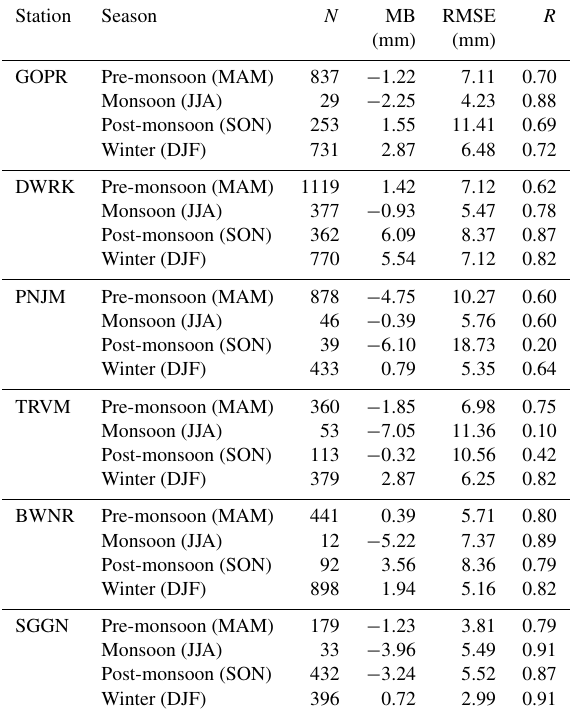
From Fig. 5, the Taylor diagram evaluates the skill character- istics in terms of RMSE, correlation coefficient and standard deviation of the annual distribution of IPWV retrieved from CAMS with 19 GNSS IPWV stations at different geographi- cal locations (Fig. 5) over the Indian subcontinent during the period of 1 January 2018 to 31 December 2018. The root mean square error (RMSE) between CAMS reanalysis and GNSS data retrievals of 9 inland stations out of 10 stations lies between 3 and 7 mm, except for Nagpur (NGPR) station where it is 9 mm. The values of the correlation coefficient (CC) and bias for inland stations lie in the range from 0.88 to 0.99 and from − 3.0 to + 3.0 mm, except Pune, which is − 6.69 mm (Table 5). The root mean square error (RMSE) for seven coastal sta- tions out of eight stations lies between 3 and 7 mm, except for Bhubaneswar (BWNR) where it is 14.0 mm. The values of CC and bias lie in the range from 0.78 to 0.98, except for BWNR, which is 0.48, and from − 2.0 to + 2.0 mm, except for BWNR, which is + 7.5 mm. The values of CC and bias for the desert station (SGGN) are 0.88 and − 1.4 mm